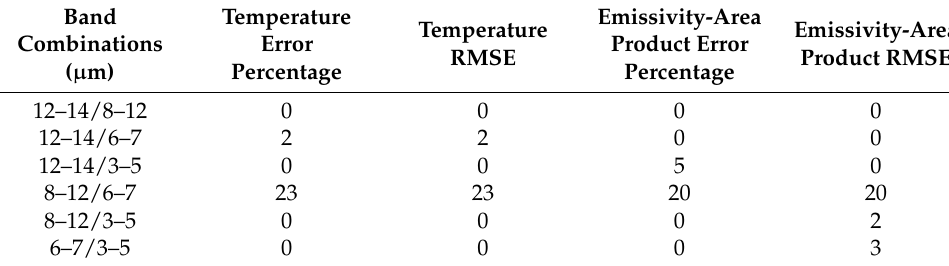
Table 3. Statistics of dominant results of different band combinations.